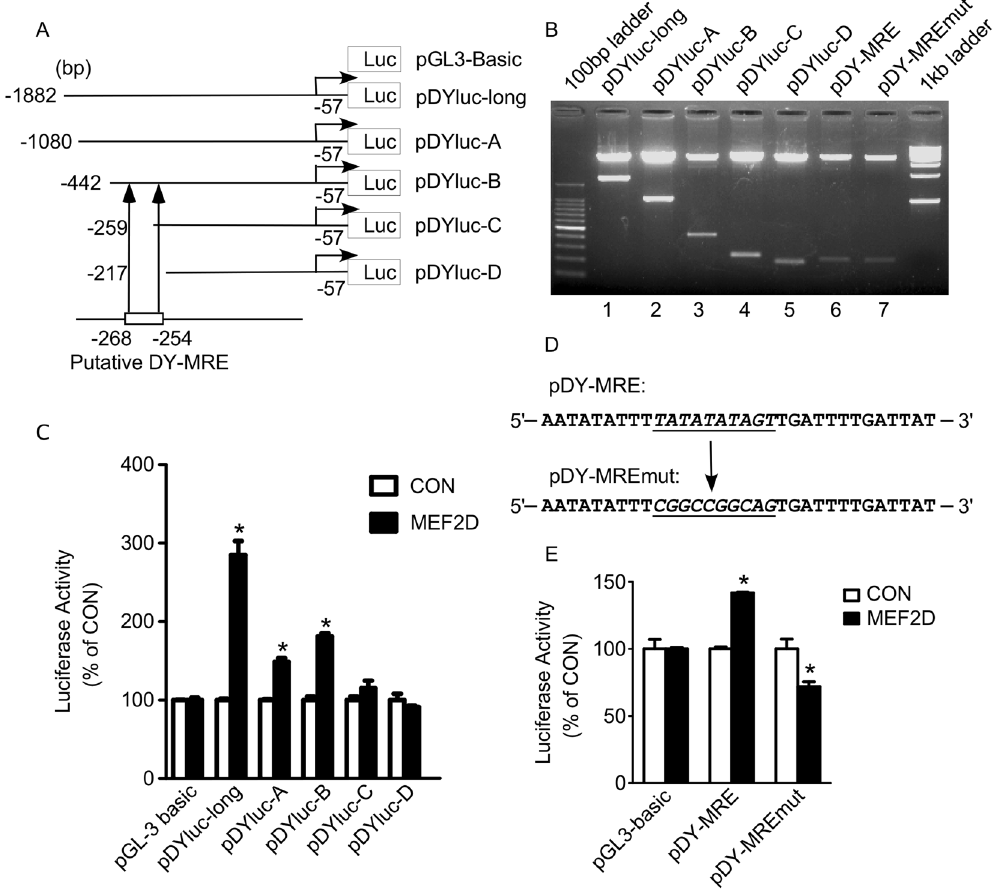
Figure 3. Identification of MEF2 responsive element on DYRK1A promoter. ( A ) Schematic diagrams of the DYRK1A isoform 5 promoter truncation constructs consisting of a 5 ′ -flanking region with serial deletions cloned into the pGL3-Basic plasmid in front of the luciferase reporter gene (Luc). Arrow indicated the direction of transcription. The numbers represent the end points of each construct. + 1 is the translation start site. ( B ) The truncation plasmids were confirmed by sequencing and restriction enzyme digestion on a 1.2% agarose gel. Vector size is 4.7 kb, and the DYRK1A gene 5 ′ -flanking fragment inserts ranged from 0.2 to 1.8 kb. ( C ) DYRK1A promoter truncation constructs were transfected into HEK293 cells with MEF2D expression plasmid or empty vector. Dual luciferase assay was performed 48 h after transfection. pGL3-Basic was used as the negative control. Values represent means ± SEM; n = 3; * P < 0.01 by Student’s t test. ( D ) Comparison of mutant sequence and original sequence of putative DY-MRE site at DYRK1A promoter region. ( E ) pDY-MRE and pDY-MREmut were transfected with MEF2D expression vector or empty vector into HEK293 cells. pGL3-basic was used as negative control. Dual luciferase assay was performed 48 h after transfection. Values represent means ± SEM; n = 3; * P < 0.05 by Student’s t